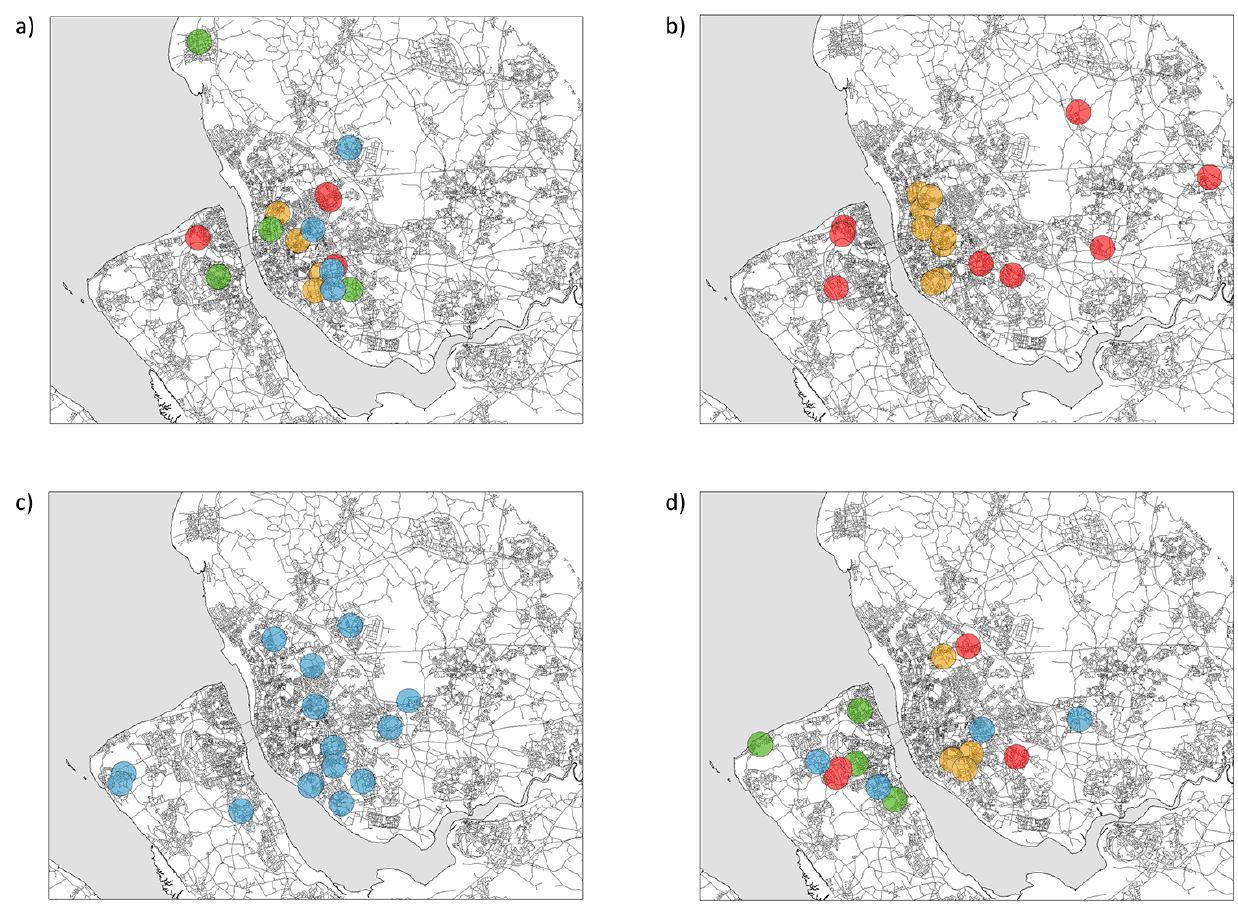
Figure 12. Geographical distributions of the four sample types; a) maximum variation, b) intensity, c) morphological ho- mogeneity and d) socio-economic